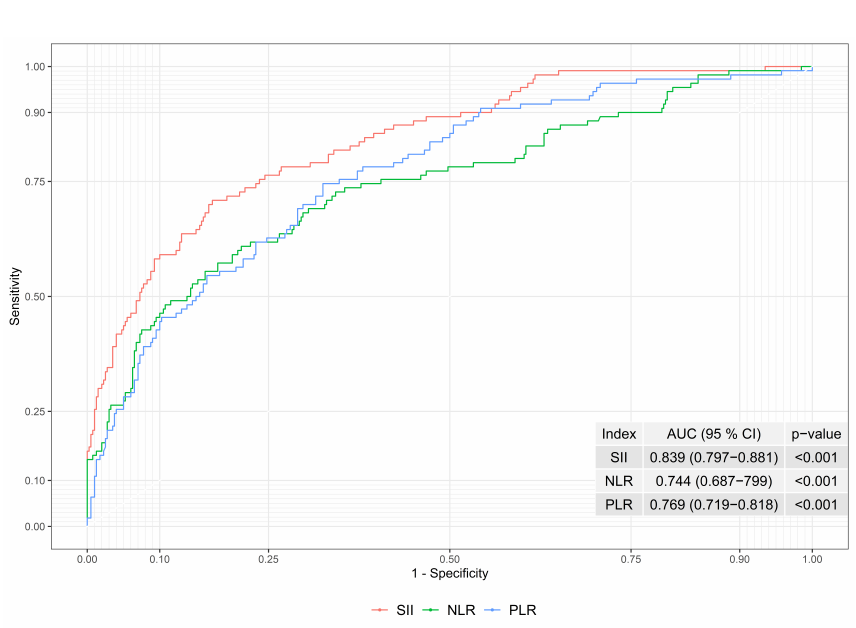
Figure 1. ROC Curves of Indexes of SII, NLR and PLR. The results for the identification of approaches to identifying the gray zone are pre- sented in Figures 2–4 and in Table 4. The lower and upper limits of the gray zone for the uncertain interval approach were 1186.576 and 1565.088. The number of patients in between these limits was 40, and 9 of them had no-reflow. Moreover, the patients who had lower values than the lower limit of the gray zone were classified as having normal flow, whereas the patients who had higher values than the upper limit of the gray zone were classified as having no-reflow. Accuracy, sensitivity, and specificity were